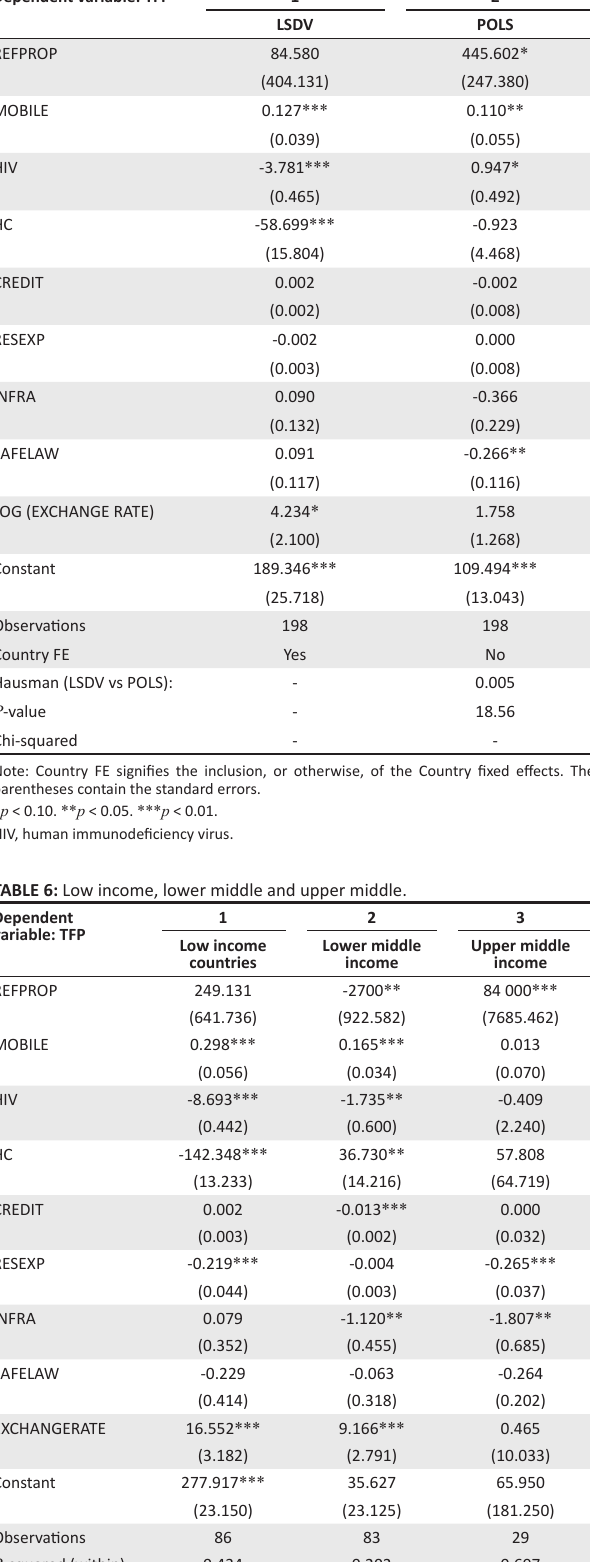
TABLE 5: Pooled Ordinary Least Squares (POLS) and Least Squares Dummy Variables (LSDV). Dependent variable: TFP